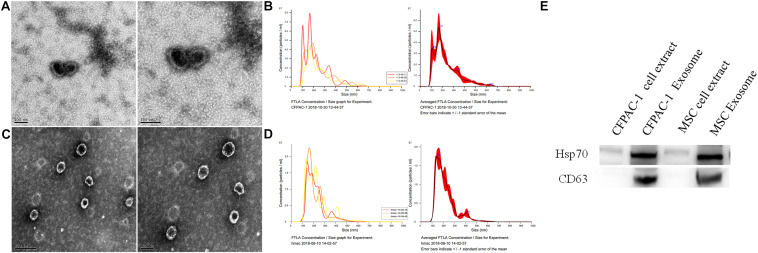
Exosome detection. Transmission electron microscope (TEM) analysis (A) and Malvern particle size detection (B) for exosomes from human pancreatic cancer cell line (CFPAC-1); TEM analysis (C) and Malvern particle size detection (D) for human mesenchymal stem cells (hMSCs). Detection of CFPAC-1- and hMSC-derived exosomes markers by western blot analysis (E).